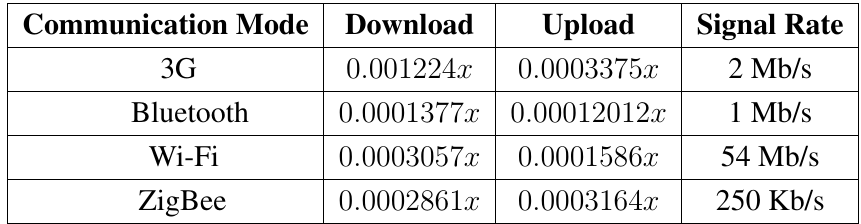
Table 4. The energy consumption of smart phones in joules with regard to the transferred data x in byte and the related signal